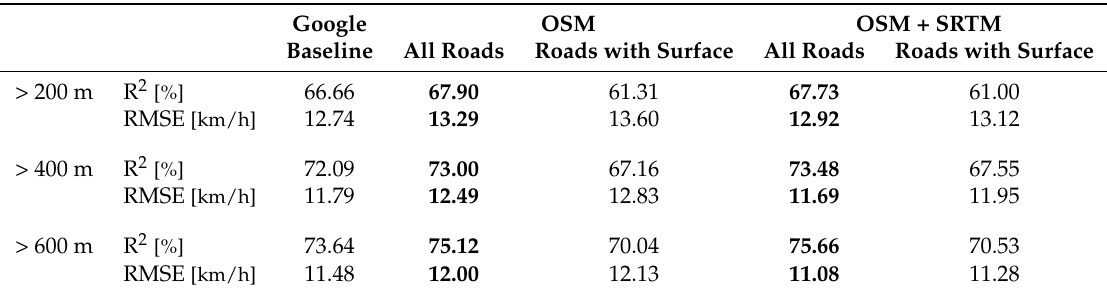
Table 3. Comparison of the R 2 and RMSE (Root mean square error) of the BM regions (Chile) for all links over 200m, 400m and 600m, respectively. The maximum value of each row with only OSM data and with OSM and SRTM data is highlighted in